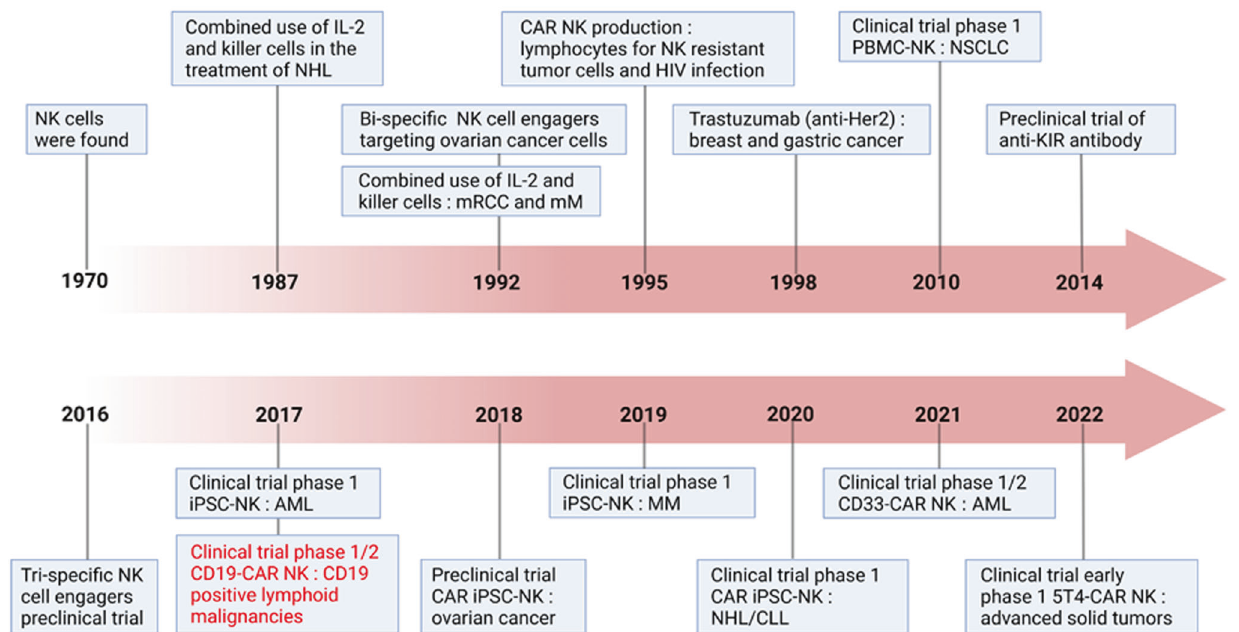
Fig. 1 The development of immunotherapy based on NK cells. Applications of various NK cell strategies in preclinical and clinical trials are listed. Since the discovery of NK cells in 1970s, NK cells have been used in clinical treatment. The combination of IL-2 and killer cells in the treatment of non-Hodgkin ’ s lymphoma (NHL), 302 metastatic RCC (mRCC), 303 and metastatic melanoma (mM), starting from 1987. Antibodies enhancing NK cell effector function were produced starting from 1992, including NK bi-speci fi c monoclonal antibody targeting ovarian cancer cells in 1992, 304 Trastuzumab (anti-Her2) in the treatment of breast cancer and gastric cancer, in 1998, anti-KIR antibody preclinical test in 2014, 305 and tri-speci fi c NK cell engagers preclinical test in 2016. 306 Clinical trials using ex vivo expanded peripheral blood mononuclear cell (PBMC)-derived NK cells for non-small cell lung cancer (NSCLC) were started in 2010, 307 while iPSC-derived NK (iPSC-NK) cells were used for AML treatment in 2017, 308 and for multiple myeloma (MM) in 2019. 309 CD4 zeta chimeric receptors were fi rstly introduced into NK cells and showed highly effective at killing target cells expressing HIV gp120 in vitro in 1995. 22 Recently, a variety of clinical phase I or II trials were started, including Phase1/2 CD19-chimeric antigen NK cells for CD19-positive lymphoid malignancies in 2017 (NCT03056339), Phase1/2 CD33- CAR NK cells for AML treatment in 2021, 310 and 5T4-CAR NK cells for treating advanced solid tumors (NCT05194709) in 2022. Preclinical trial for CAR iPSC-NK cells for ovarian cancer were started in 2018, 26 while clinical trials of CAR iPSC-NK cells for treating NHL or chronic lymphoblastic leukemia (CLL) in 2020. 28 Created with